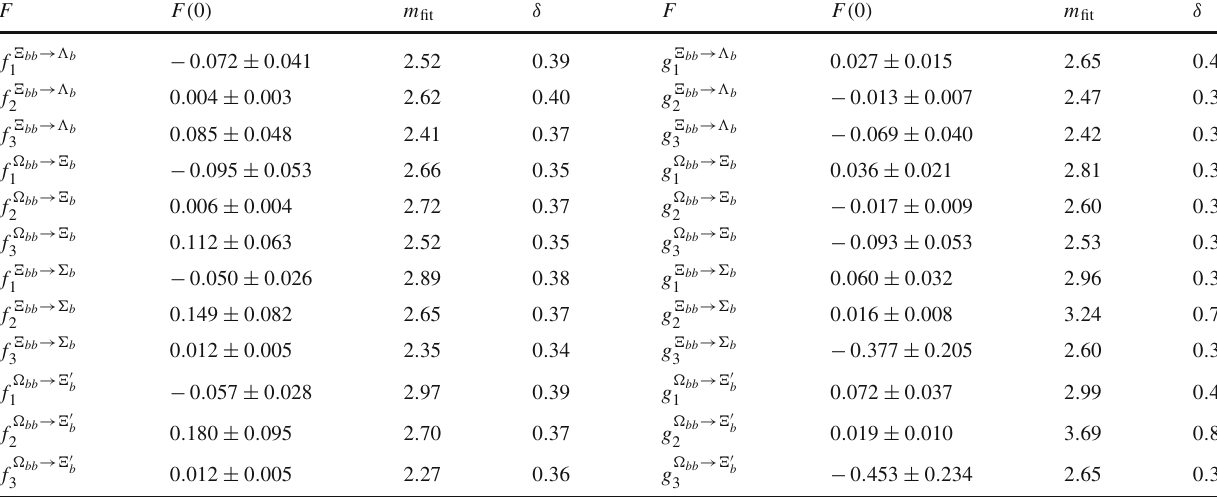
→ (cid:6) + . For F ( 0 ) , we have only considered the uncertainty from the heavy quark b bb